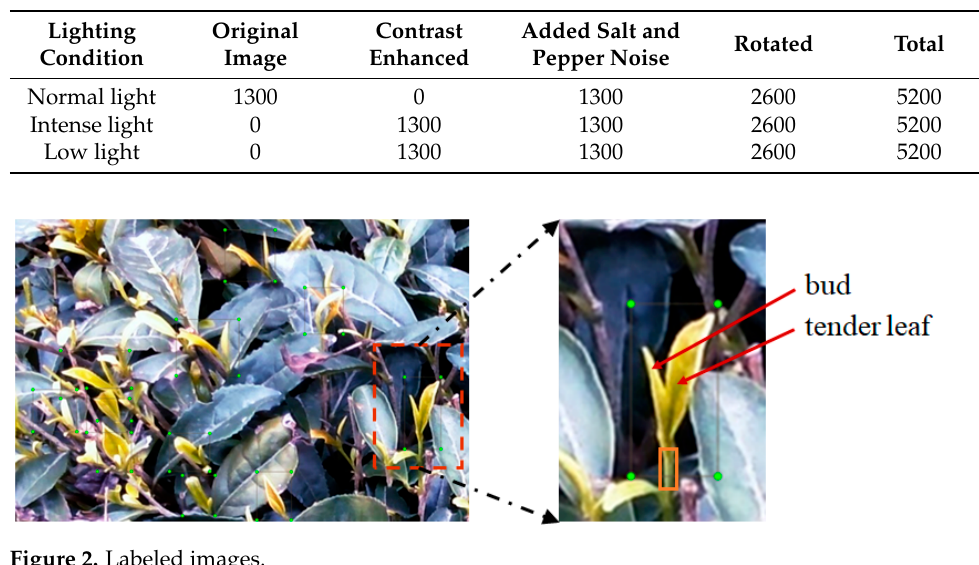
Table 1. Dataset